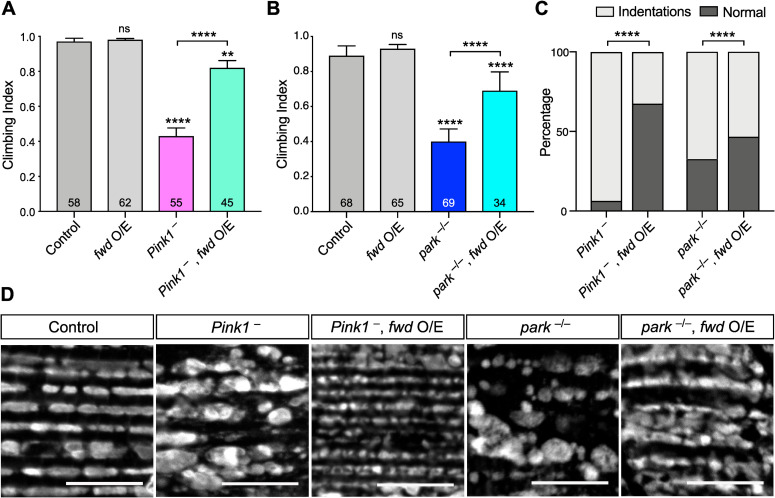
fwd overexpression partially suppresses Pink1/parkin phenotypes.(A, B) Climbing assay of control, Pink1 or parkin mutants with or without ubiquitous fwd overexpression. Charts show mean ± 95% confidence interval (CI); number of animals analysed is shown in each bar. Significance was analysed by Kruskal-Wallis test with Dunn’s post-hoc correction for multiple comparisons. Comparison is against the control unless otherwise indicated; ** P<0.01, **** P<0.0001; ns, non-significant. (C) Analysis of thoracic indentations evident in Pink1 or parkin mutants in the presence or absence of fwd overexpression, induced by da-GAL4. Significance was determined by Chi-squared test. **** P<0.0001. (D) Confocal microscopy analysis of mitochondrial integrity, visualised by anti-ATP5A immunostaining, in flight muscles of the indicated genotypes. Transgenic expression was mediated via Mef2-GAL4. Scale bar = 10 μm. Full genotypes are given in S1 Table.